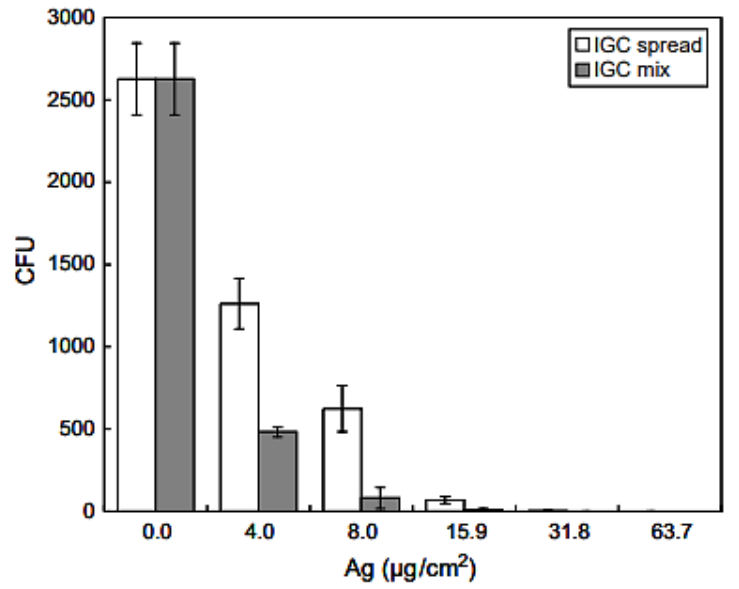
Figure 5. Antimicrobial effect of silver nanoparticles on bacteria spread on plates containing silver nanoparticles and on bacteria mixed with silver nanoparticles and then spread on a plate. The IGC method was used to produce these nanoparticles [101].